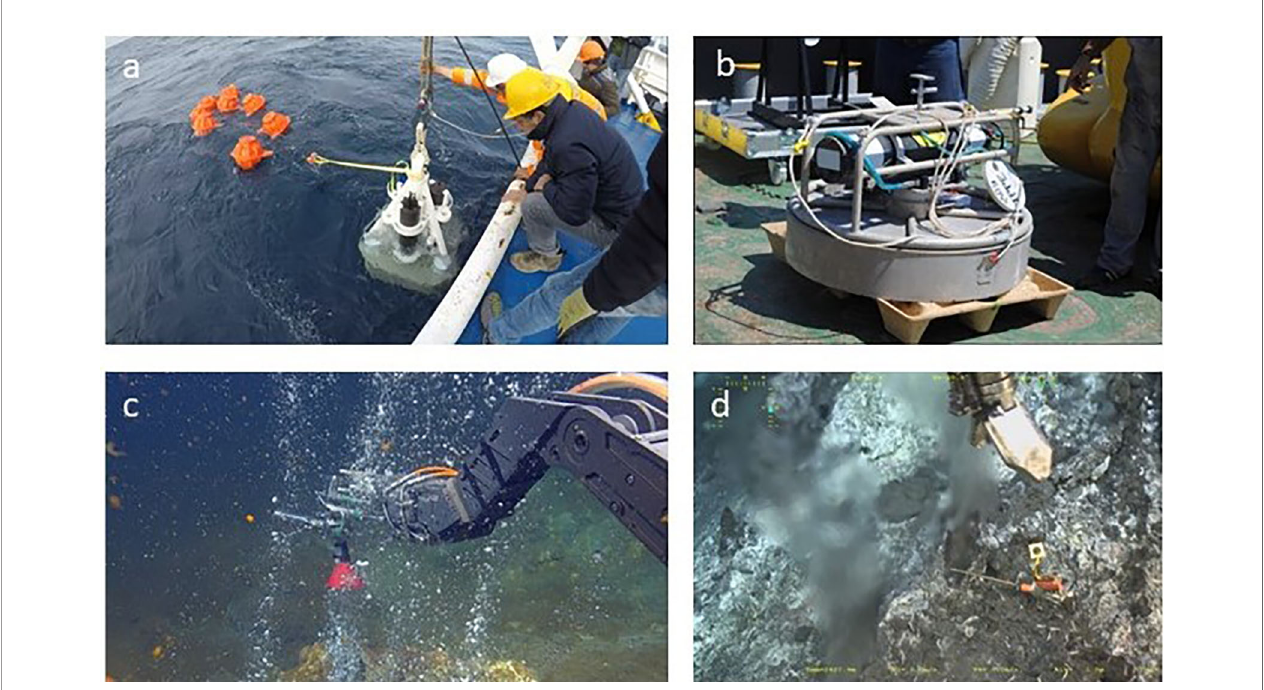
FIGURE 5 | Some of the novel sensors and monitoring systems that will be deployed in the SANTORY observatory: (A) automated sea fl oor system for geochemical multi-parametric monitoring (i.e., dissolved CO 2 , H 2 S, O 2 , temperature, pressure, conductivity, pH, water column current, and turbidity, hydrophone) (Longo et al., 2021a), (B) IPGP (France) pressure gauge deployed at Santorini during the 2012 Caldera cruise (Vilaseca et al., 2016) measuring vertical sea fl oor movements, (C) discrete gas-tight sampler above Kolumbo vent (Carey et al., 2013), (D) Temperature sensor deployed at the Lucky Strike hydrothermal fi eld during the Bathyluck 2009 cruise (Barreyre et al.,